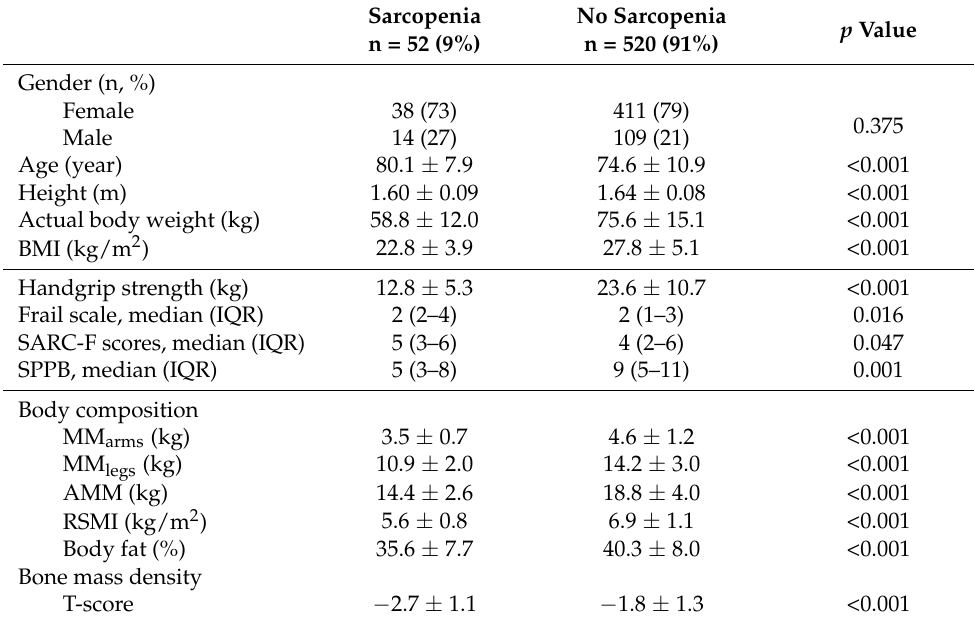
Table 2. Comparison of sarcopenic and nonsarcopenic patients.